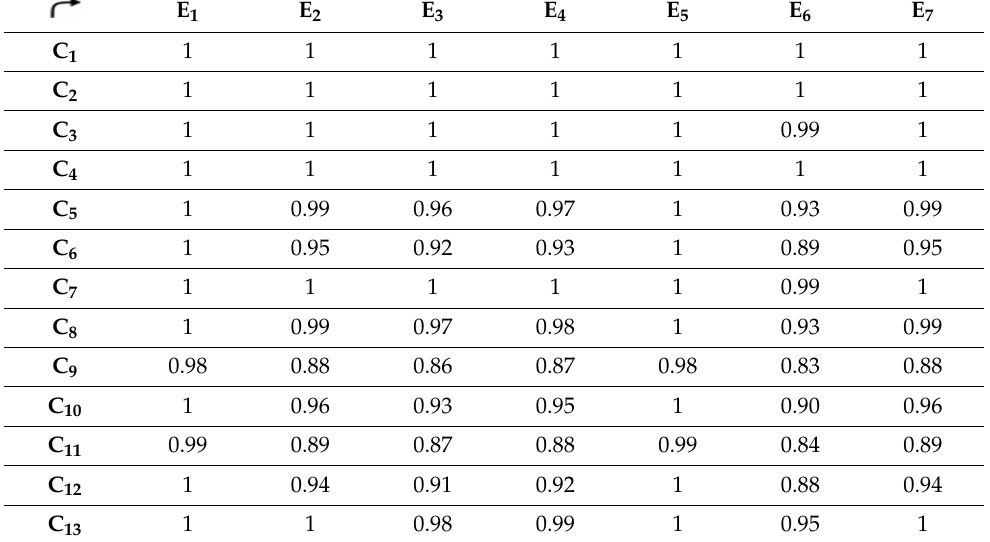
Table 7. Cause–effect incident estimation matrix [ (cid:101) M ] .